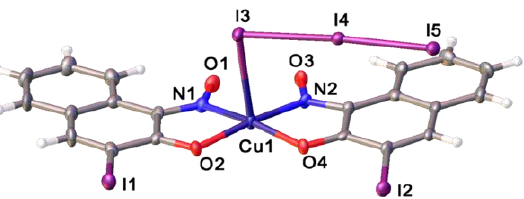
Figure 4. View of the molecular structure of 4 obtained from XRD study. Nonhydrogen atoms are given as probability ellipsoids of atomic displacements ( p = 0.5). Table 2. Selected bond lengths for the Cu II complexes.